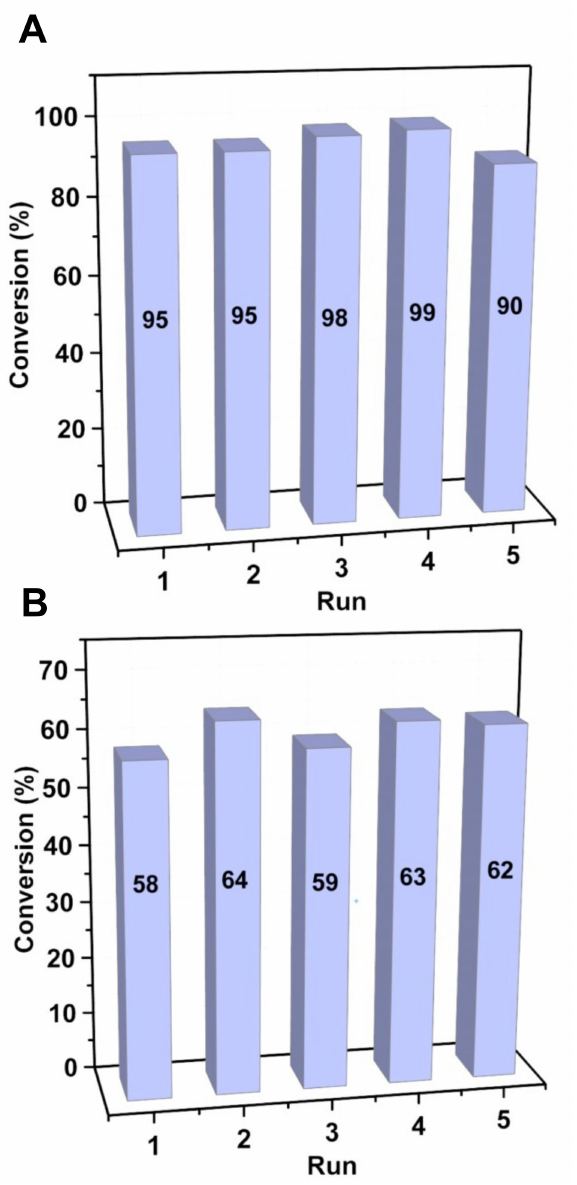
Figure 5. Recycling experiments using ( A ) Pd 0 /poly(DVB)-13%; ( B ) Pd 0